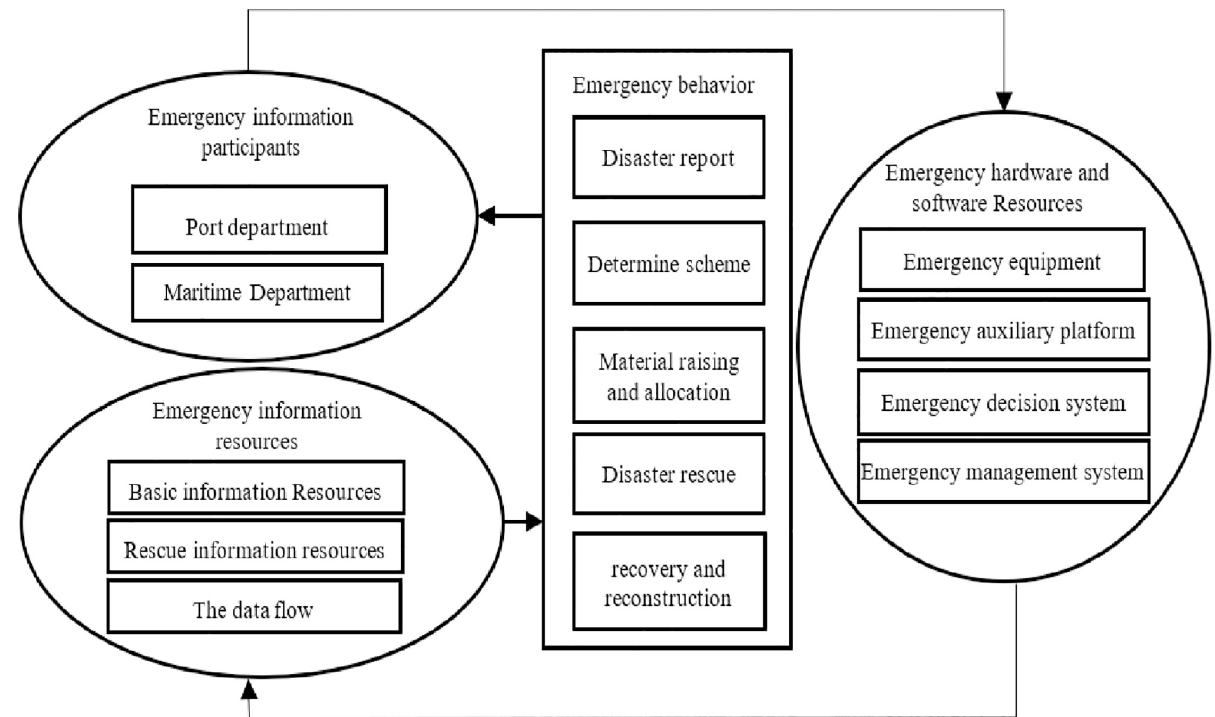
Fig 1. The relationship between emergency information participants, emergency information resources, emergency behaviors, and hardware and software.